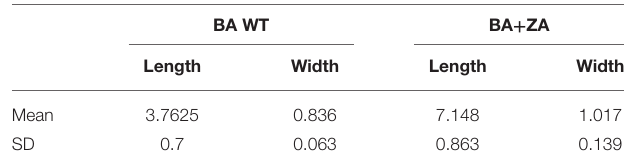
TABLE 3 | The cell dimensions ( µ m) of B. anthracis cells in presence (BA+ZA) or absence (BA WT) of ZA.